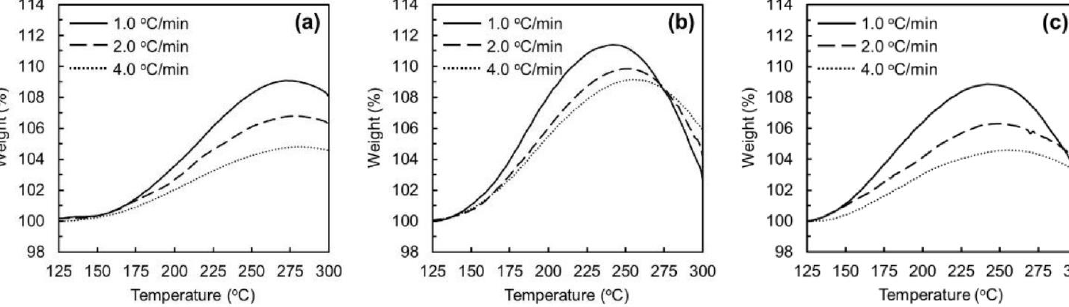
Figure 4. TGA profiles of oxygen uptakes in the oxidation–stabilizations of mesophase pitch fibers with different heating rates: ( a ) 0.1 MPa, ( b ) 0.5 MPa, and ( c ) 1.0 MPa.